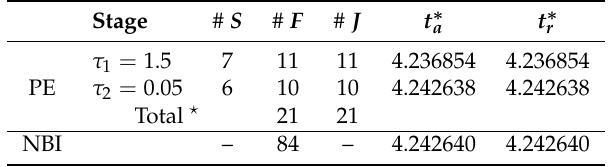
Table 1. Computational cost for multi-objective optimization problem (MOP)